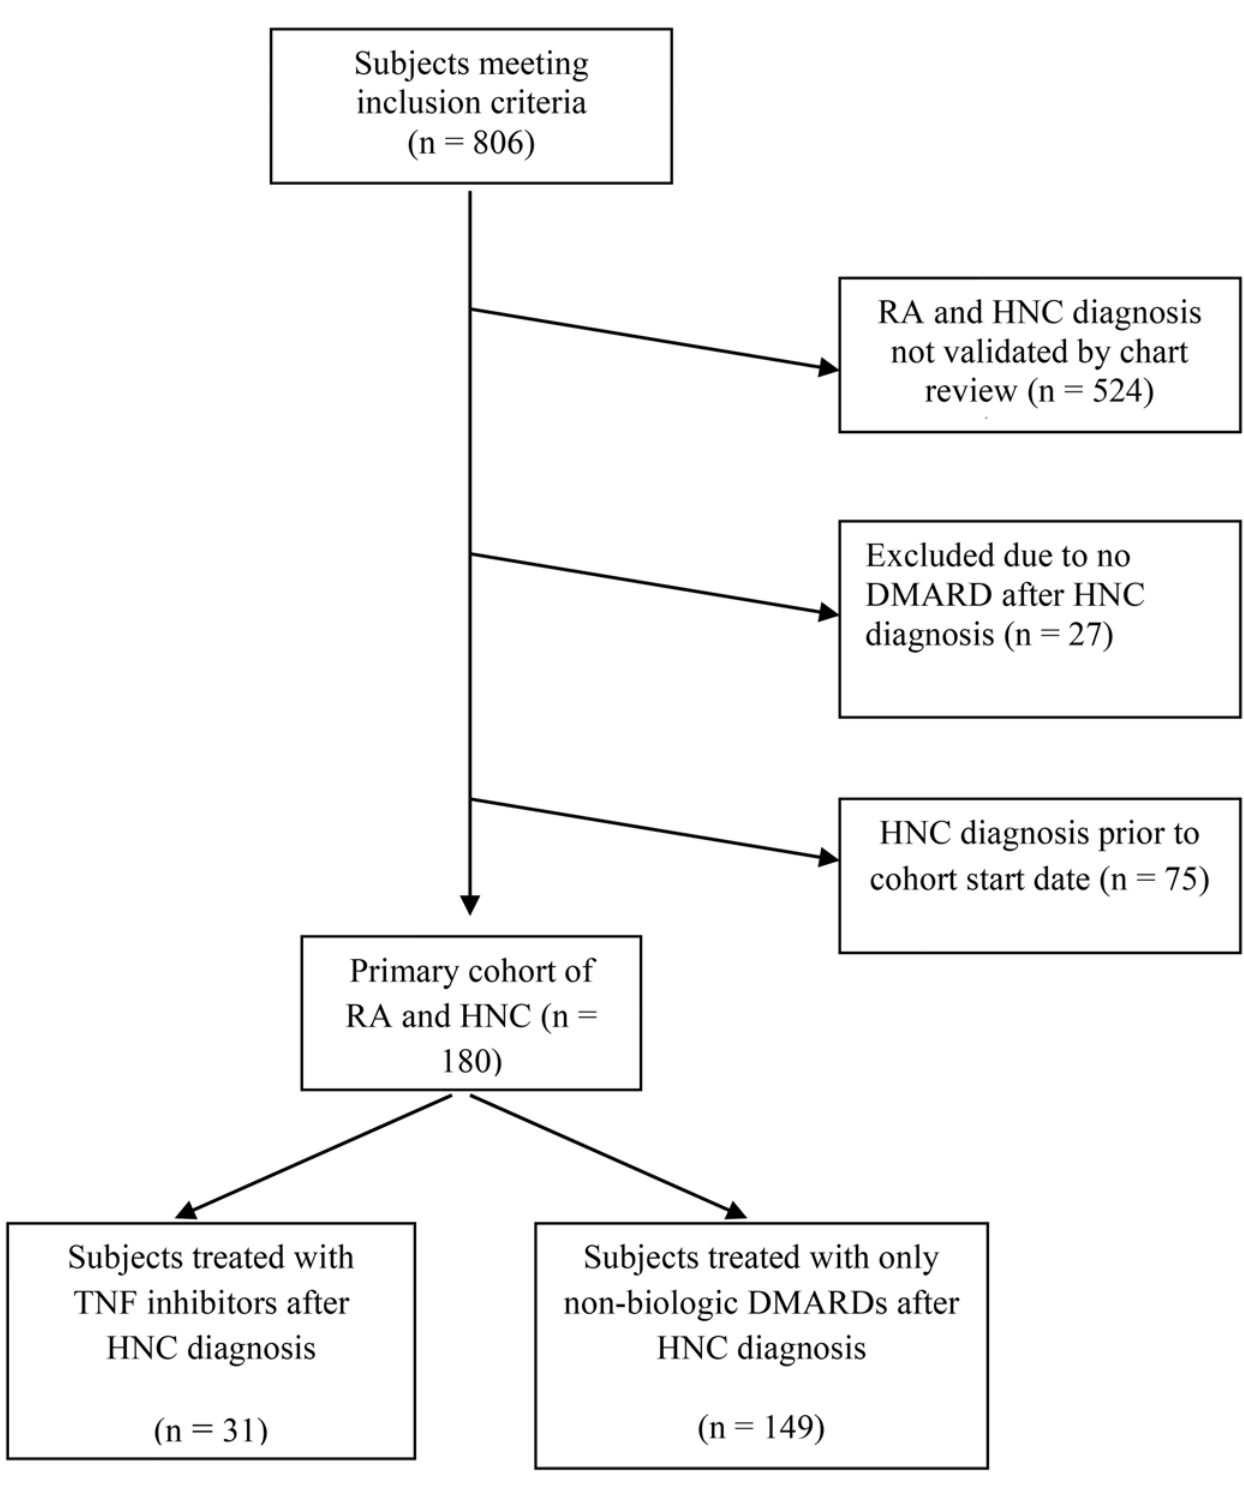
Fig 1. Study flow diagram.